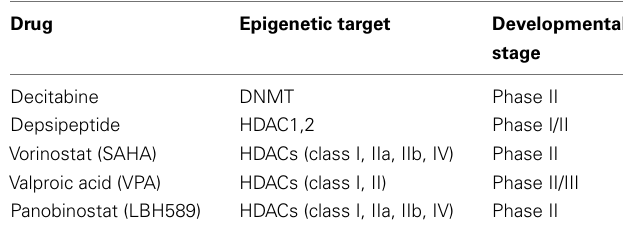
Table 2 | Epigenetic drugs in clinical trials for the treatment of advanced thyroid cancer (www.clinicaltrials.gov